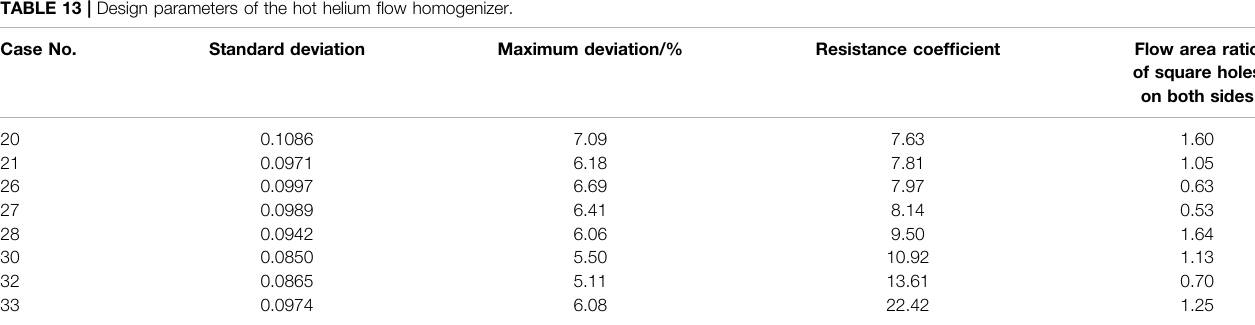
TABLE 13 | Design parameters of the hot helium fl ow homogenizer. Case No. Standard deviation Maximum deviation/% Resistance coef fi cient Flow area ratio